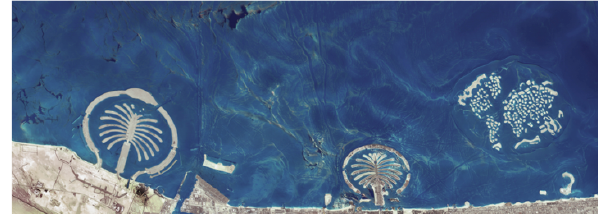
Figure 3. MRC Image of the Palm Island in Dubai The HRC is a 1m-class video sensor using a 14 MPixel CMOS detector (operated at 3 Frames Per Second) with a nominal 3.8 km by 5.7 km footprint (at nadir for 400km altitude) which has a Bayer filter on the detector with three spectral channels: blue, green and red. The HRC is attached to a Bi-axial Pointing Platform (BPP), steering the camera in the roll and pitch directions allowing the camera to dwell on a target for up to 90 seconds.